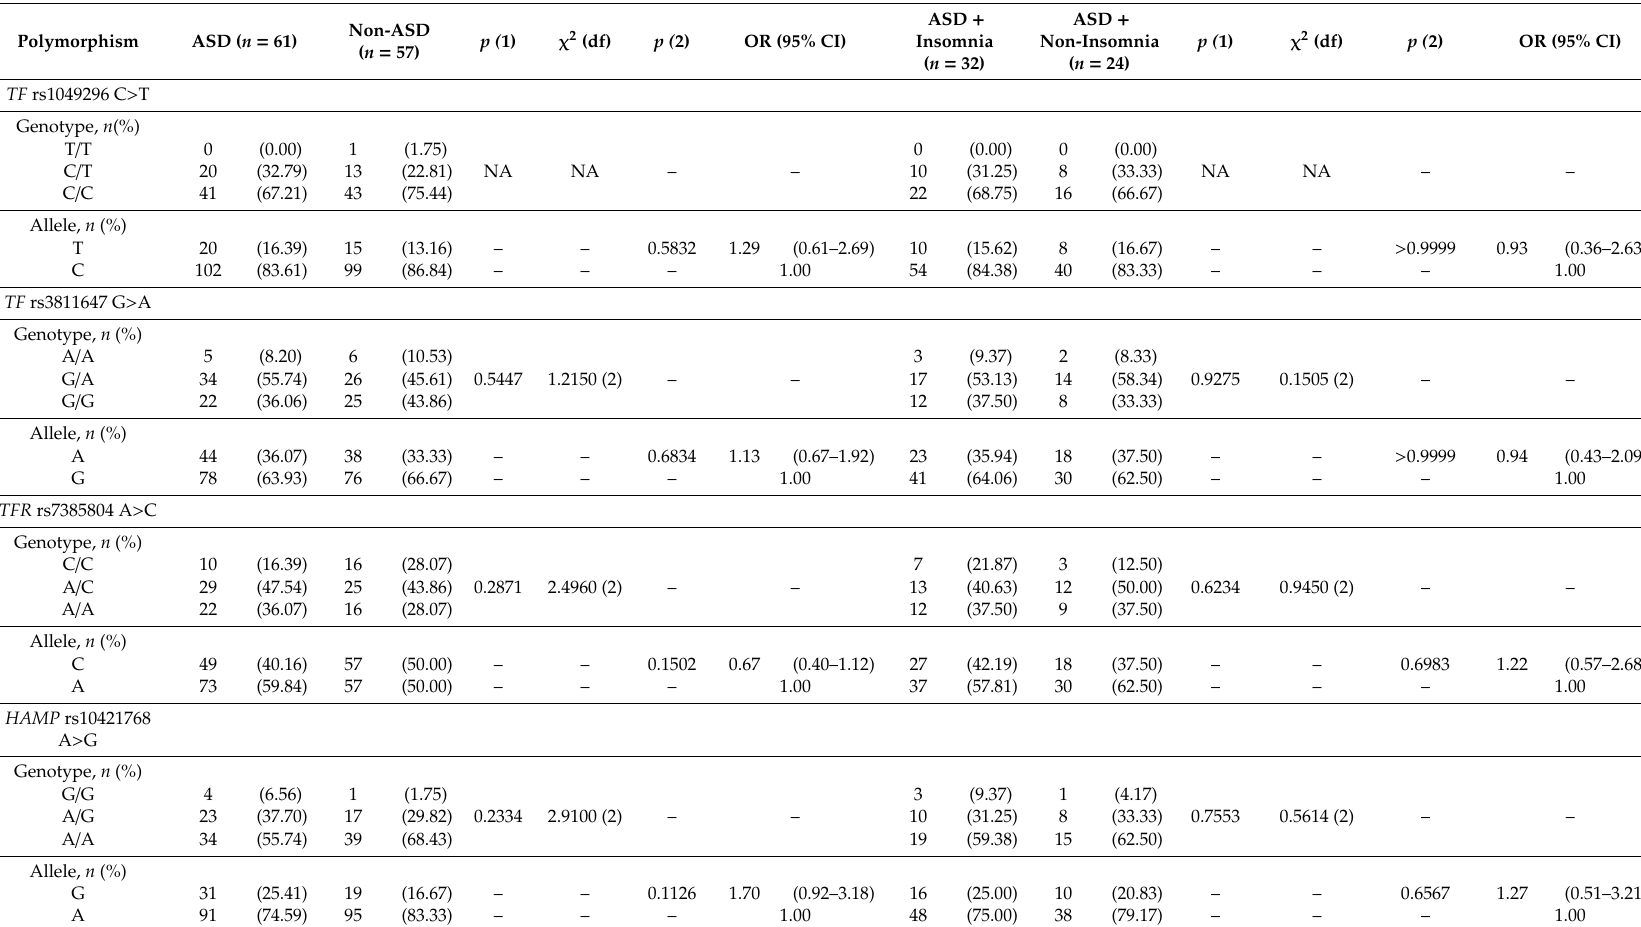
Table 1. Genotype and allele distributions of the TF, TFR and HAMP SNPs in individuals with ASD, without ASD, with ASD and insomnia and with ASD without